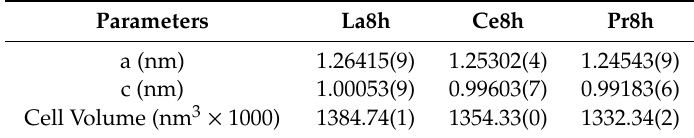
Table 2. Lattice parameters and unit cell volume of RECO 3